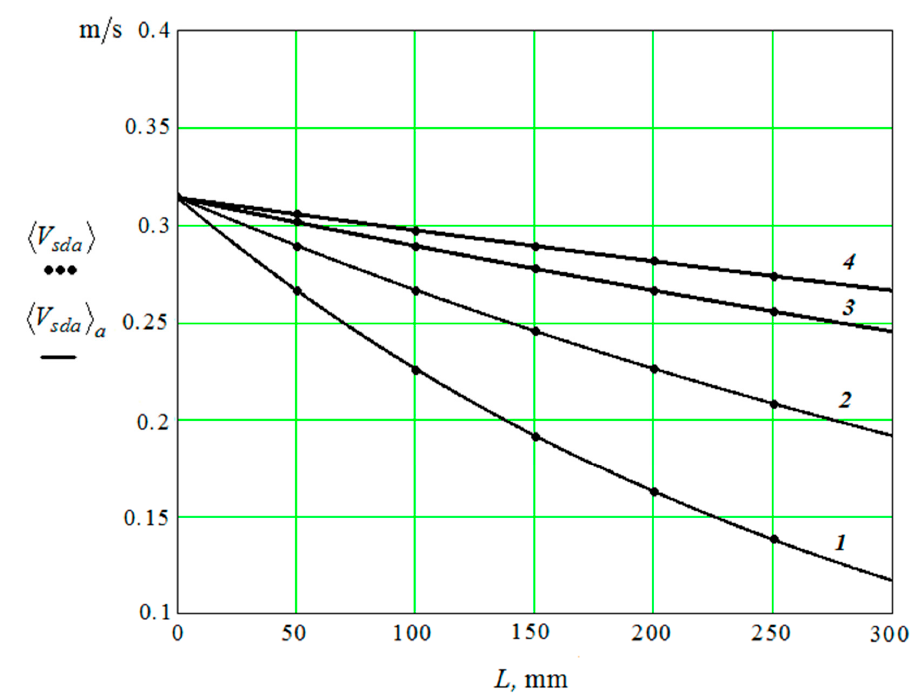
Figure 8. Dependence of the speed of granules movement (cid:104) V sda (cid:105) on the distance to the reservoir working surface.